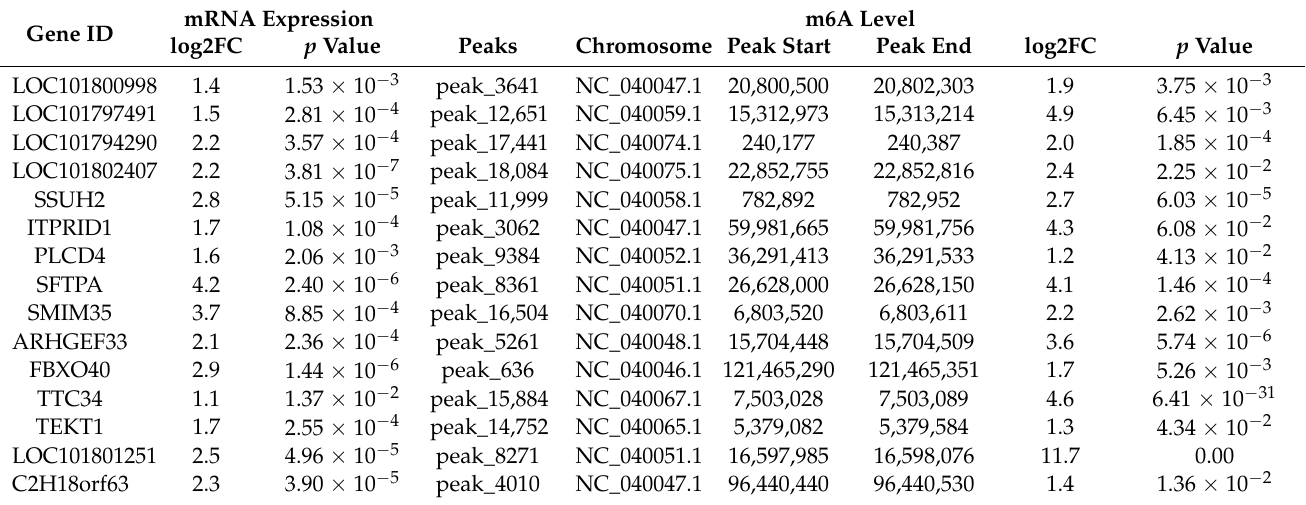
Table 3. List of hyper-up methylated genes that were significantly different between E19 and E13.